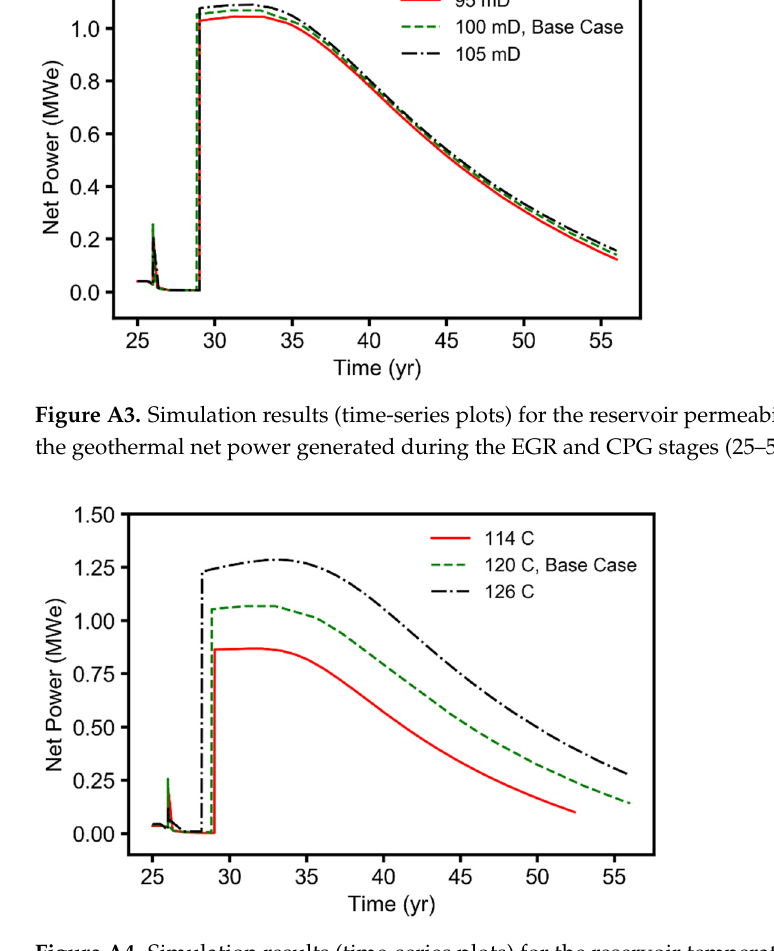
Figure A4. Simulation results (time-series plots) for the reservoir temperature parameter, showing the geothermal net power generated during the EGR and CPG stages (25–55 years).